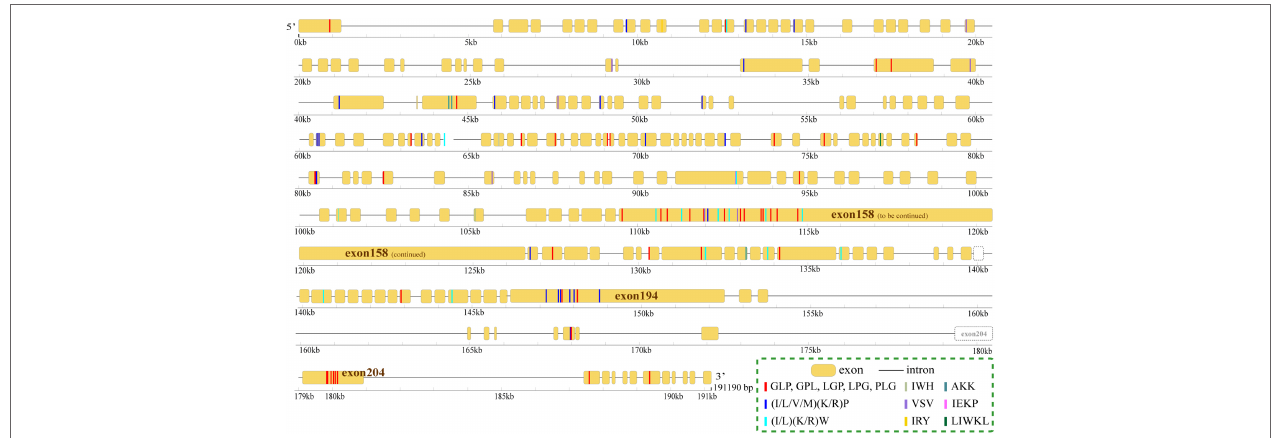
FIGURE 3 | Distribution of AHTPs in the longest titin encoded by the gene HE002169. Yellow bars and the black lines between them represent the exons and introns, respectively. Rulers under them mark their length. The coloured lines inside each exon bar stand for AHTP hits, and each colour represents one AHTP